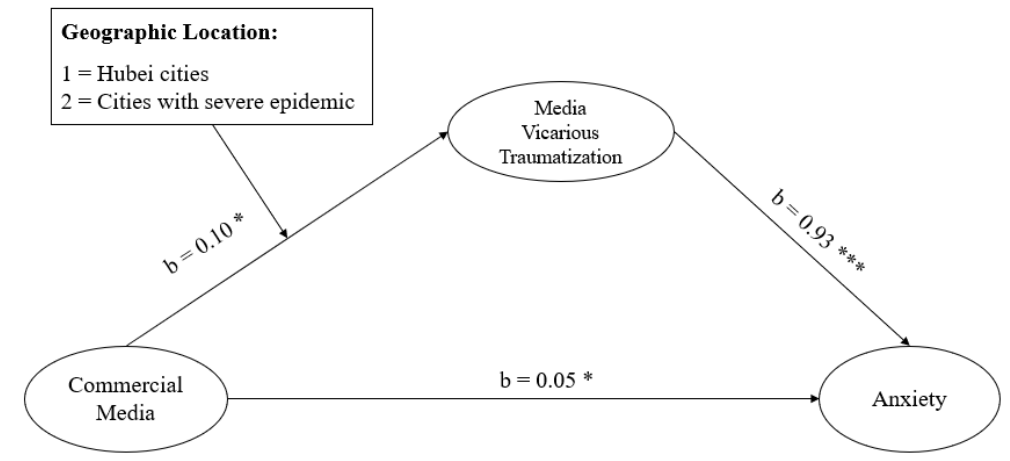
Figure 5. Moderated-mediation model. * p < 0.05; ** p < 0.01; *** p < 0.001.